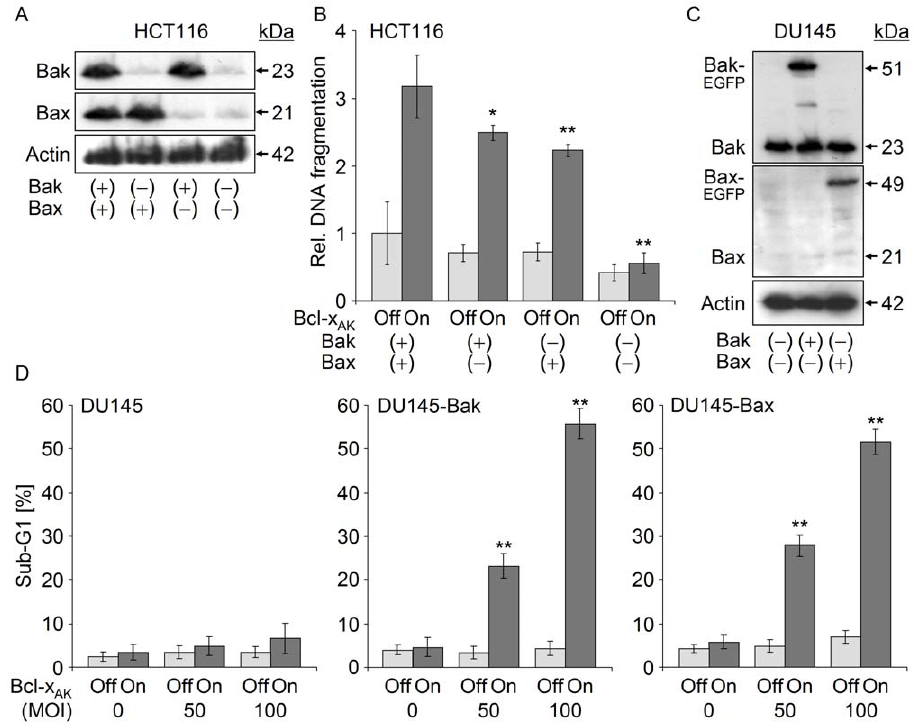
Figure 3. Bcl-x AK -mediated apoptosis depends on Bax or Bak. (A, C) Expression of Bax and Bak is shown by Western blot analysis in subclones of HCT116 and DU145, respectively. Equal loading was confirmed by incubation with b -actin. Two independent series of protein extracts revealed largely comparable expression. (B) HCT116 parental cells (Bax + /Bak + ) as well as subclones (Bax 2 /Bak + ), (Bax + /Bak 2 ) and (Bax 2 /Bak 2 ) were transduced with AdV-AK (MOI=50) and cultured under OFF or ON conditions. Relative DNA fragmentation values (apoptosis ELISA) were normalized according to the values of parental cells under OFF conditions (set to 1). (D) DU145 parental cells (Bax 2 /EGFP-Bak 2 ) as well as subclones (Bax 2 /EGFP-Bak + ) and (EGFP-Bax + /EGFP-Bak 2 ) were transduced with AdV-AK (MOI=50, 100) and cultured under OFF or ON conditions. The percentages of apoptotic cells (sub-G1 populations) are shown, as determined by flow cytometry at 48 h after transduction. (B, D) Means and SDs of triplicate values of a representative experiment are shown (each two independent experiments). Statistical significance as determined by Student’s t-test is indicated by asterisks (*, p , 0.05; **, p , 0.005), when comparing parental cells and subclones under ON conditions.